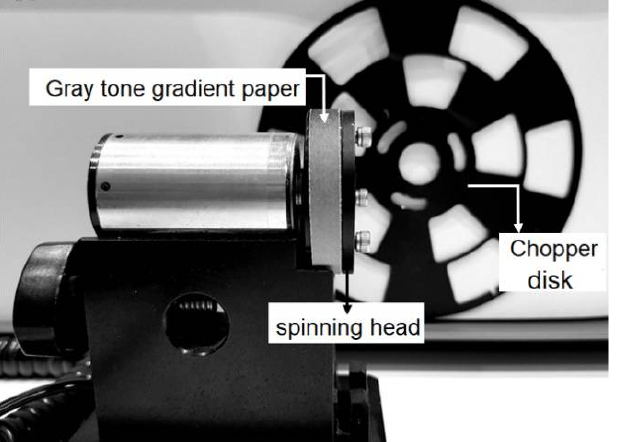
Figure 10. Attached gray tone gradient paper on spinning head and chopper disk used as targets for remote encoder